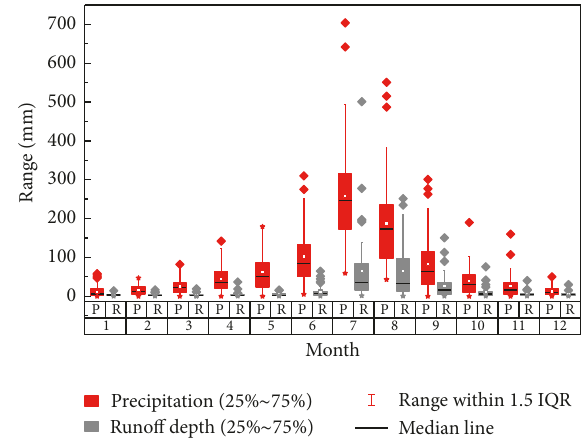
Figure 2: Long-term monthly average precipitation and runoff depth of the Yi River